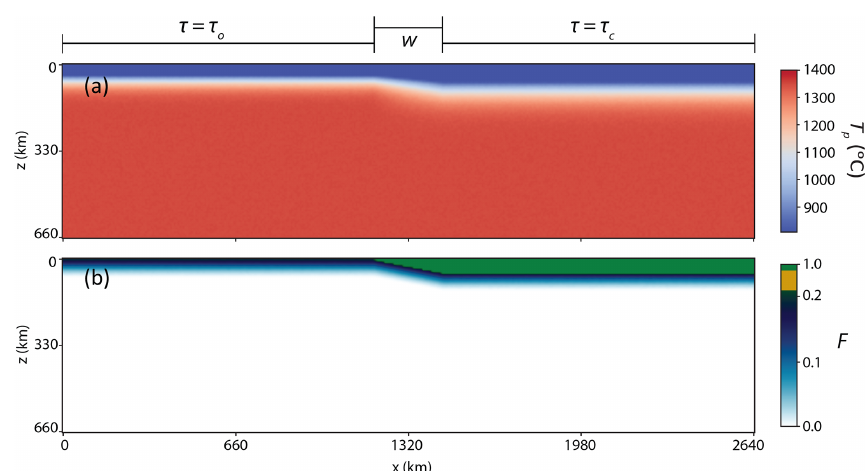
Figure 2. Initial conditions for the reference model. (a) Initial field of potential temperature T p (i.e., with the adiabatic gradient removed). (b) Initial compositional field of depletion ( F ) for the hydrous peridotite component. The areas where τ = τ o and τ = τ c , as well as w , are labeled for clarity. A comparison of the fields for different lithologies can be found in Appendix A (Fig. A2).